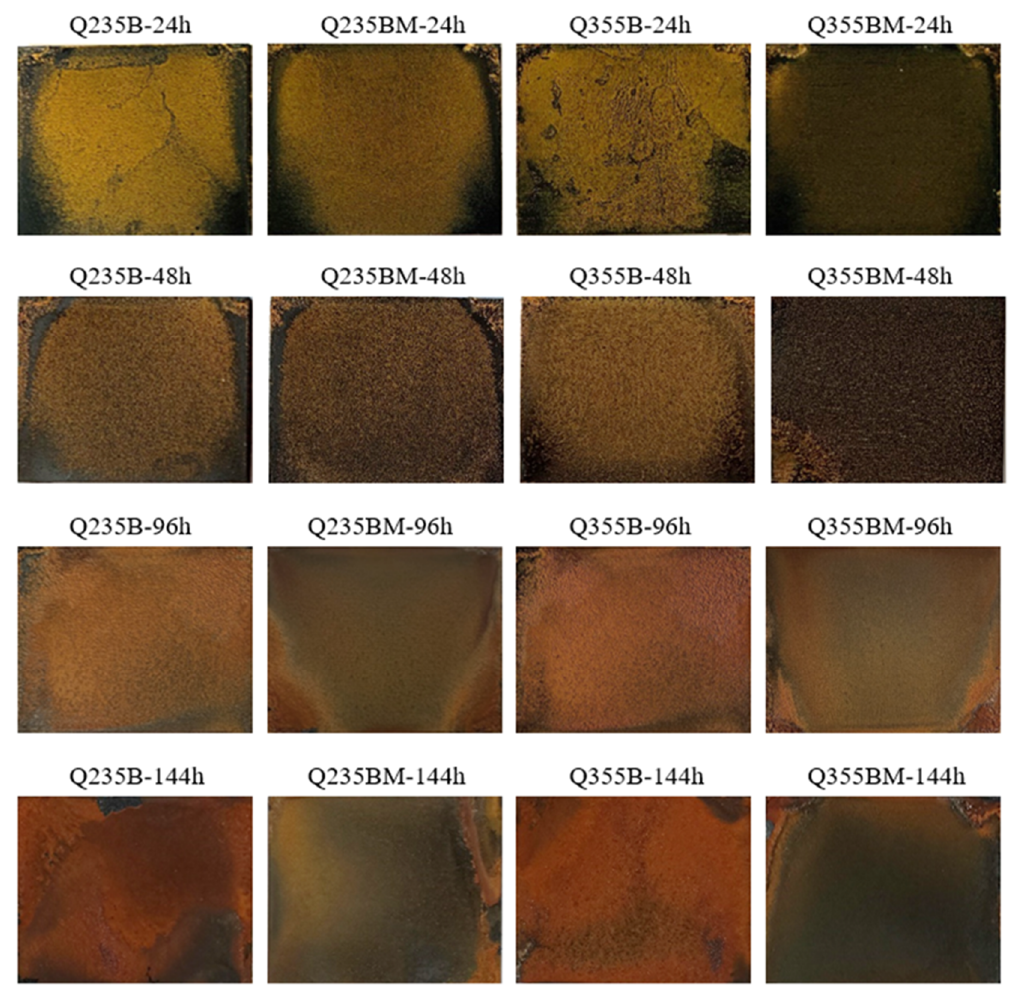
Figure 1. Surface morphology of sample rust layers after immersion tests (24–144 h).